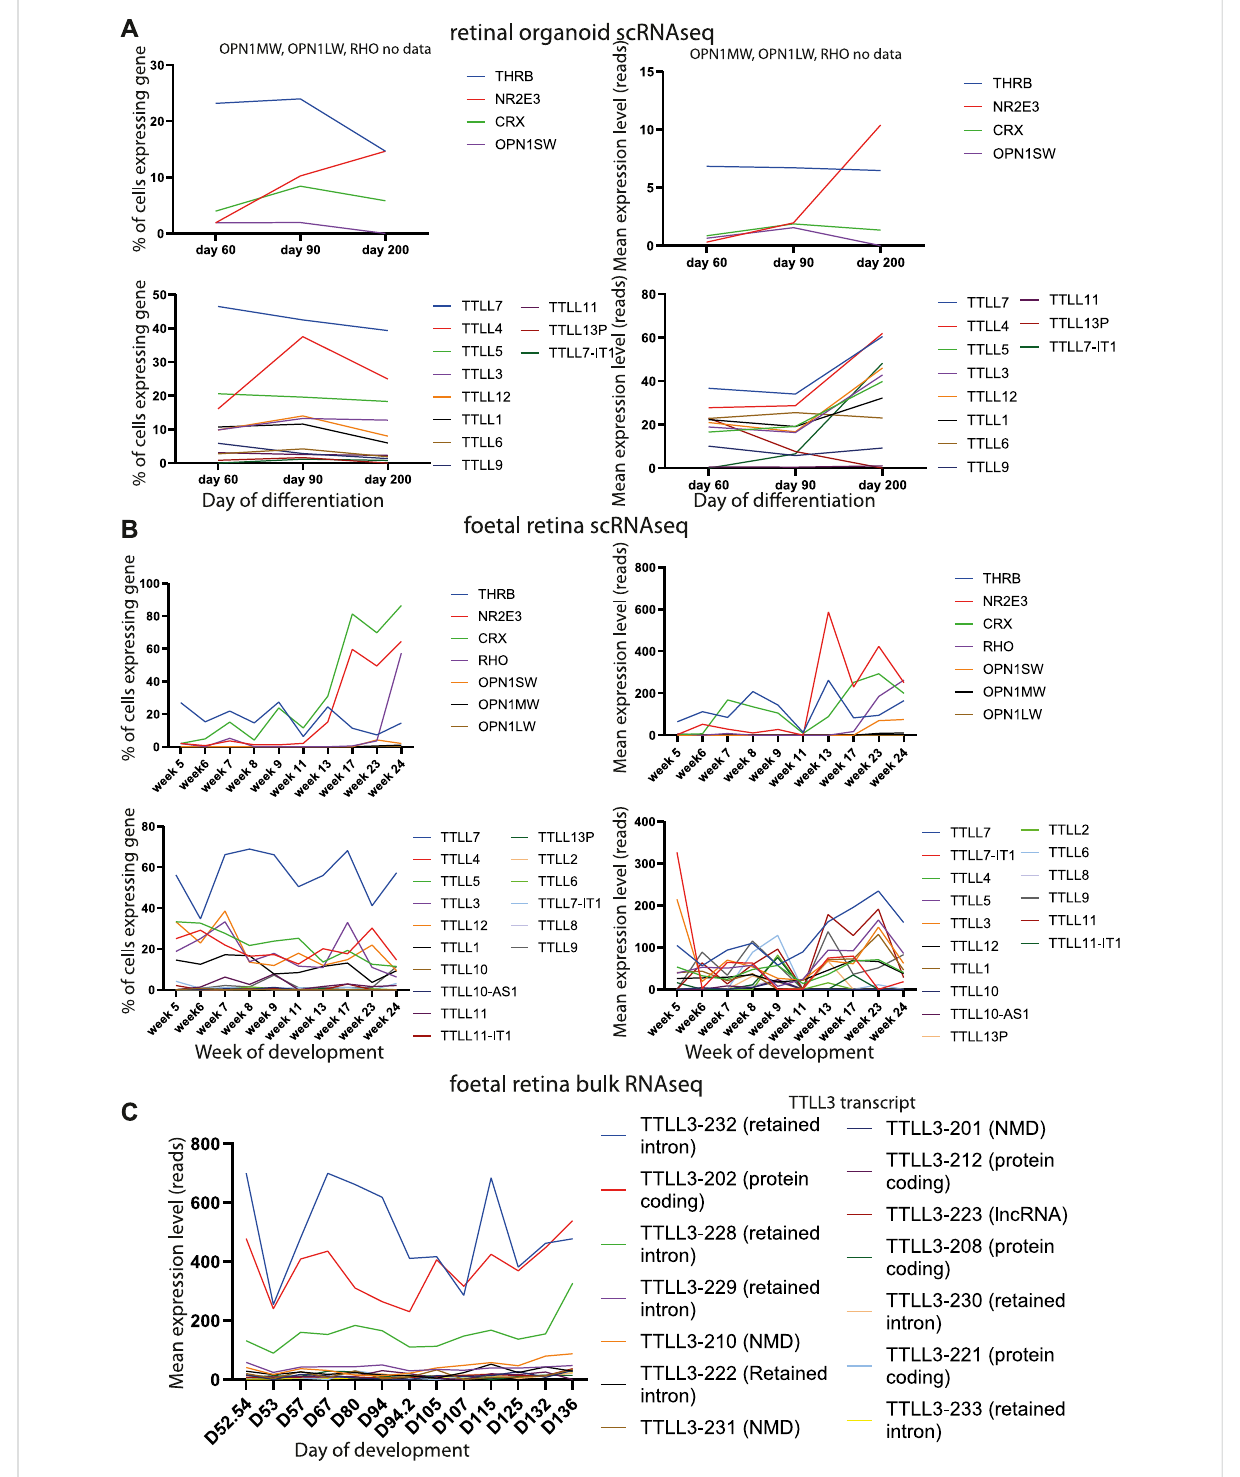
FIGURE 5 Analysis ofretinal geneandTTLLgeneexpressionindeveloping retinalorganoidsandfoetalretina. (A) Linegraphsplotting%ofcellsexpressing genes (left) and mean expression level in raw reads of genes (right) in single cell expression datasets from retinal organoids. Data are shown from genesrelatedtospeci fi cfunctionsofdifferentretinalcells(top)andTTLLgenes(bottom)atdifferentstagesofretinalorganoiddifferentiation. (B) Line graphs plotting % of cells expressing genes (left) and mean expression level in raw reads of genes (right) in single cell expression datasets from human foetal retinal. Data are shown from genes related to speci fi c functions of different retinal cells (top) and TTLL genes (bottom) at different stages of retinal development. (C) Line graphs plotting mean expression level in raw reads of genes in bulk expression datasets from human foetal retinal. Data are shown for TTLL genes at different stages of retinal